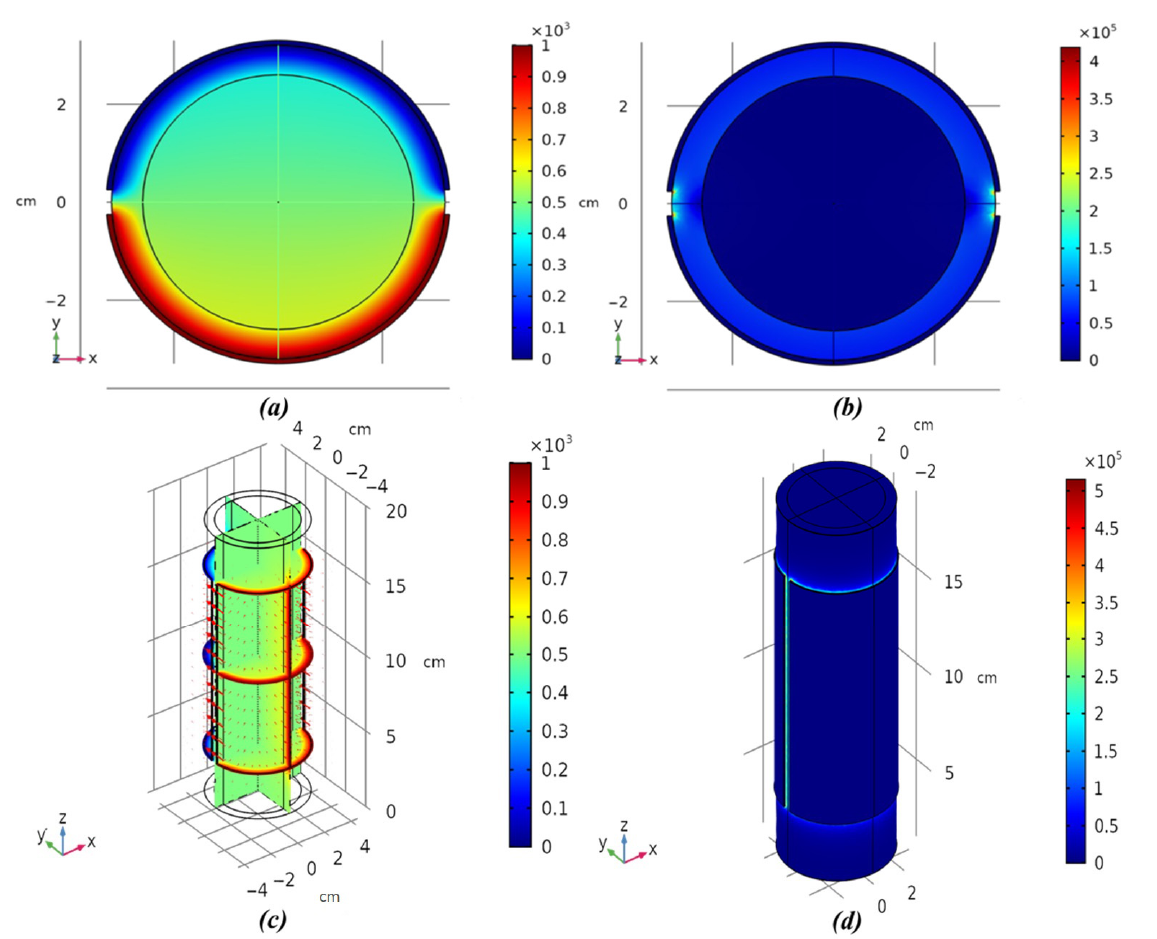
Figure 10. ( a ) Cross-section diagram of the voltage dispersion in the middle of the electrode. ( b ) Cross-section diagram of the electric field dispersion in the middle of the electrode. ( c ) Sketch of the electric field direction. ( d ) 3D view of the electric field. Table 2. Simulation results calculated by COMSOL Multiphysics for the concave sensor in the an- nular water–air regime.